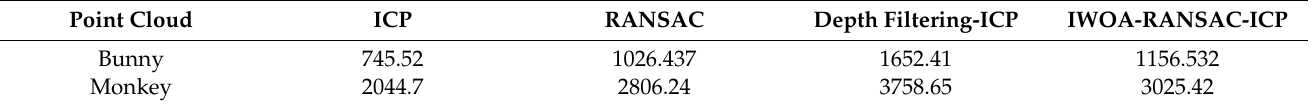
Table 1. Registration time of these three methods (ms).